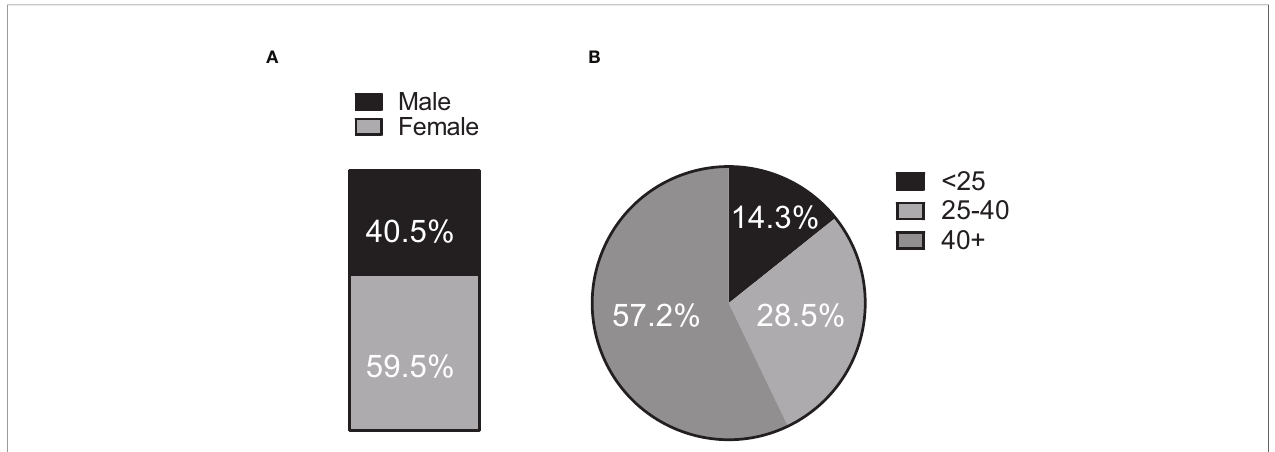
FIGURE 1 | Population demographics. 42 (n = 42)individualscontributed oral mucosal fl uid samples at timepoints spanning over 12-monthsfor the clinical study. (A) Sex representation. 17 of 42 participants (40.5%)identi fi ed as maleand 25 (59.5%)as female. (B) Age representation. Seven (7) individuals (16.6%)were younger than 25 years of age atthe timeof samplecollection,11 (26.2%)were between the ages of 25 and 40 and 24 individuals (57.2%)were older than 40 years of